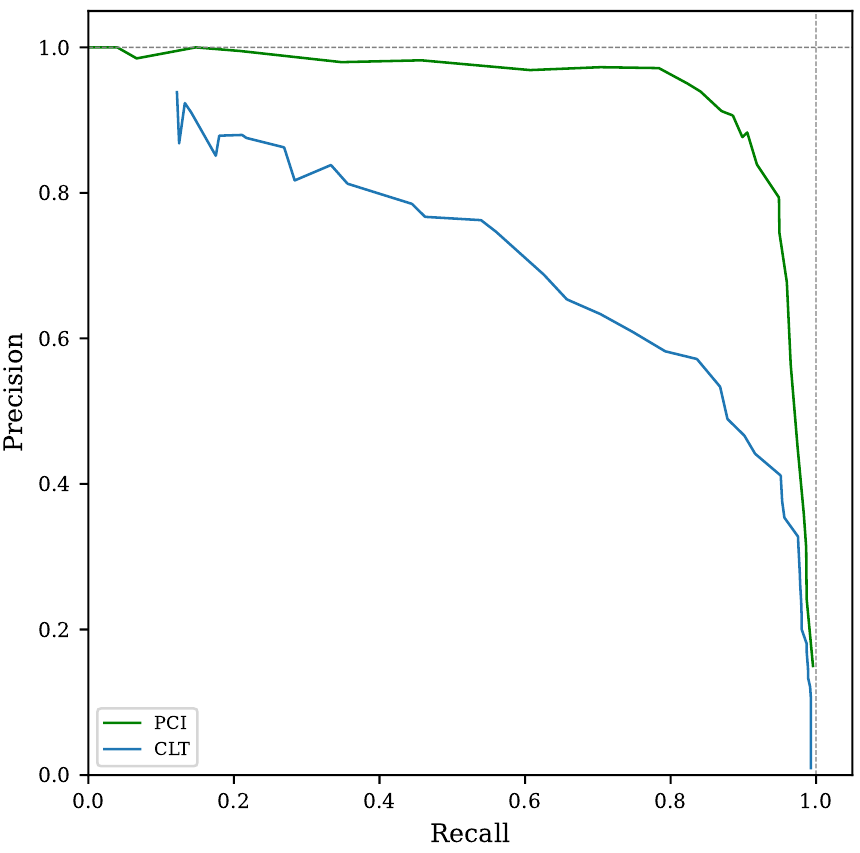
Figure 5. Precision-recall curve of event recognition counts for simple cross-level trigger (CLT) and two-stage triggering (PCI). Peak signal-to-noise ratio was set to 3 units for this